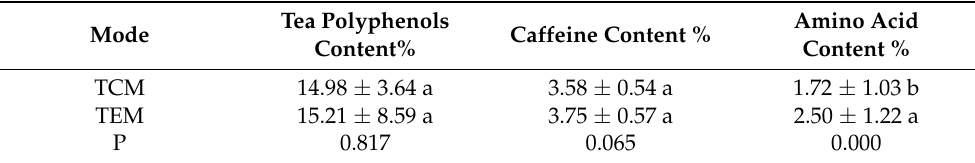
Table 4. The effects of management mode on the tea quality indices.